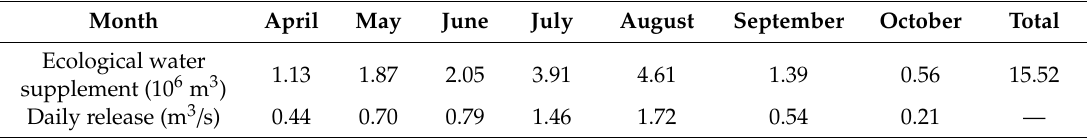
Table 7. Ecological water supplement and daily release of the Xinlicheng Reservoir from April to October.